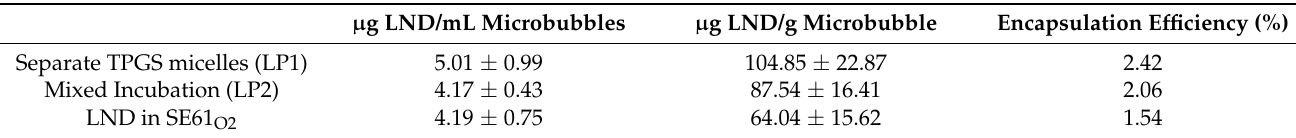
Table 4. Effect of method of dual drug incorporation on LND encapsulation.